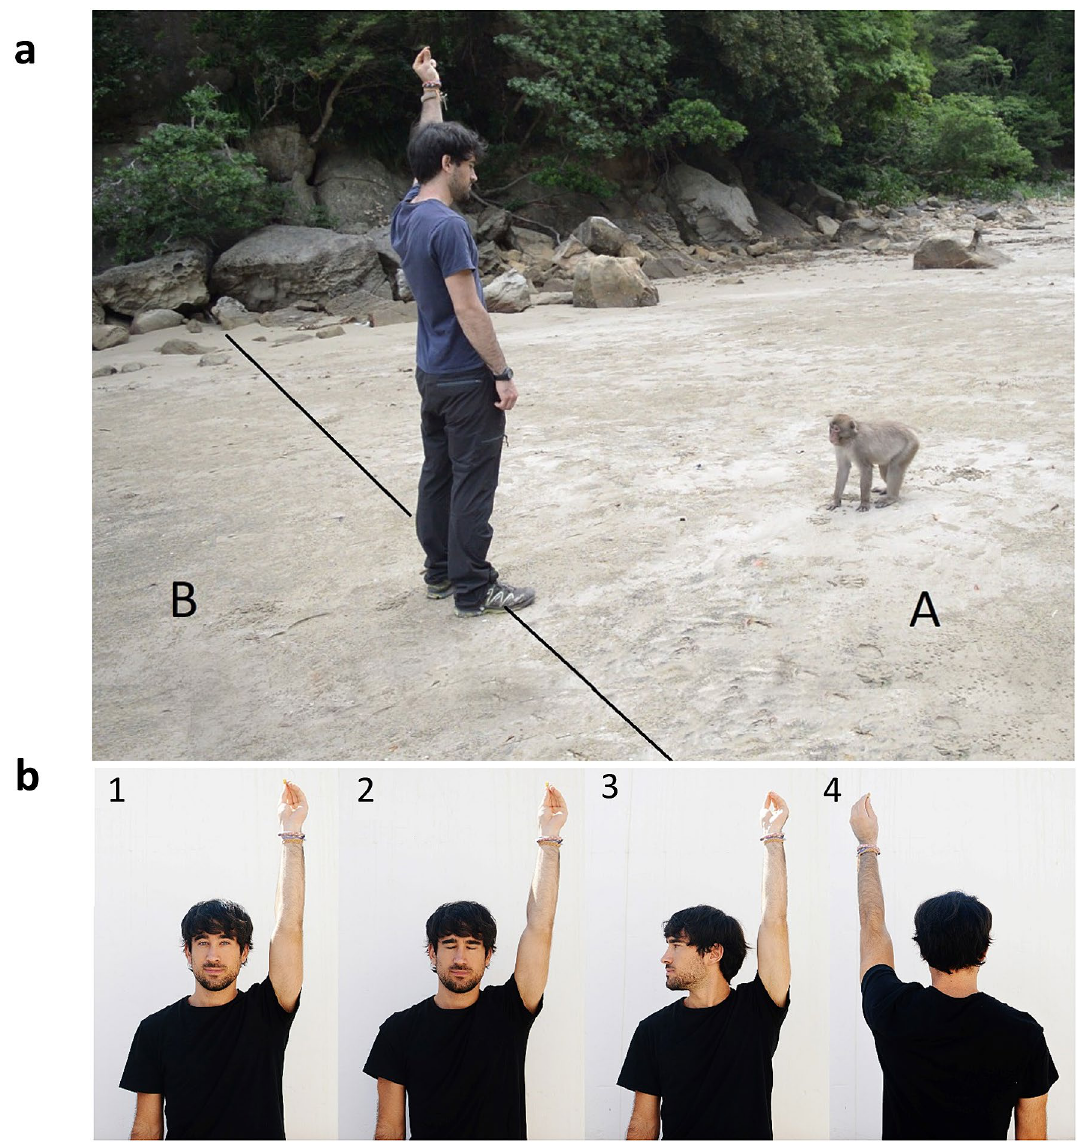
Figure 2. Set-up of Experiment 2. ( a ) Position of experimenter 1 (E1) and subject (S) at the beginning of each trial: E1 is approximately 2.5 m in front of S holding a peanut above its head. The imaginary line divides zones A and B where S can move during the test. ( b ) Experimental conditions: E1 holds a peanut over his head for 20 s with different states of attention: (1) Eyes open, (2) Eyes closed, (3) Head turned, (4) Back Both the order of trials (i.e., Experimental and Control conditions) and the position of the barriers (opaque barrier to the S’s right or left) were counter-balanced and pseudo-randomized across subjects. A total of 41 trials could not be completed and had to be repeated due to the interference of other individuals ( n = 27), the approach of S before the end of the presentation ( n = 5), experimenter error ( n = 4), and S’s refusal to participate in the task ( n = 5). From the videos, E2 coded the first choice made by S in each trial (i.e., whether S took the peanut located behind the opaque barrier or behind the transparent one). Data analysis. From the videos of the three experiments, another researcher coded a 20% of the trials.